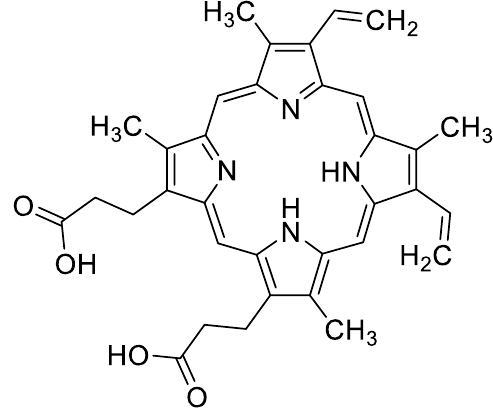
Figure 1. Molecular structure of protoporphyrin